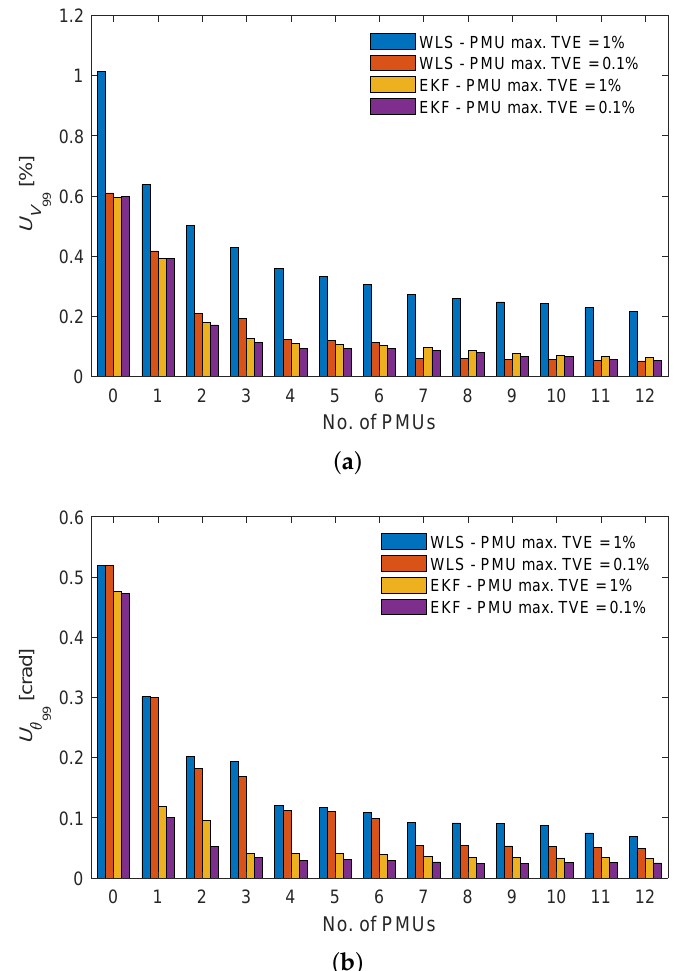
Figure 6. 99-th percentiles of ( a ) the bus RMS voltage relative estimation errors and ( b ) the phase estimation errors obtained with the enhanced EKF and the WLS algorithm when only pseudo-measurements (scenario 1) and an increasing number of PMUs with a different maximum TVE is used. The percentiles are computed over all buses and over the whole simulated year. In this case, the load profiles are included within ± 60% of the respective nominal